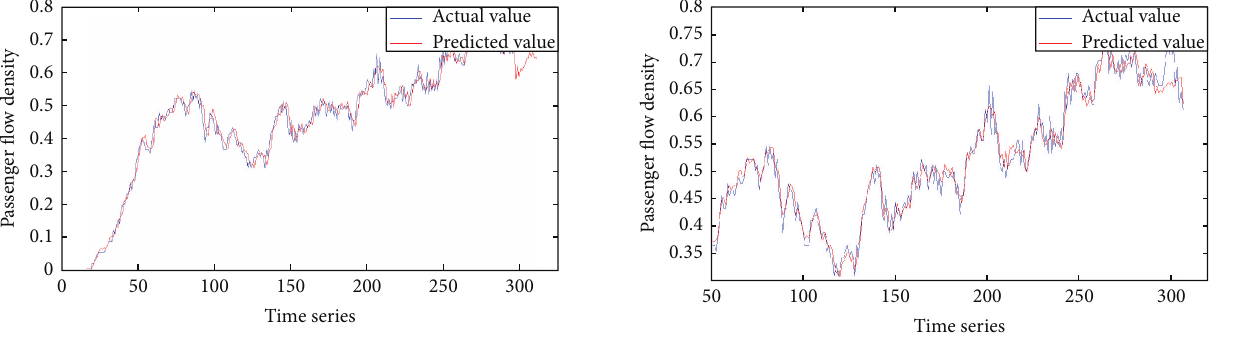
Figure 5: Comparion between actual value and forecasting value of passenger flow density based on spatio forecasting model.